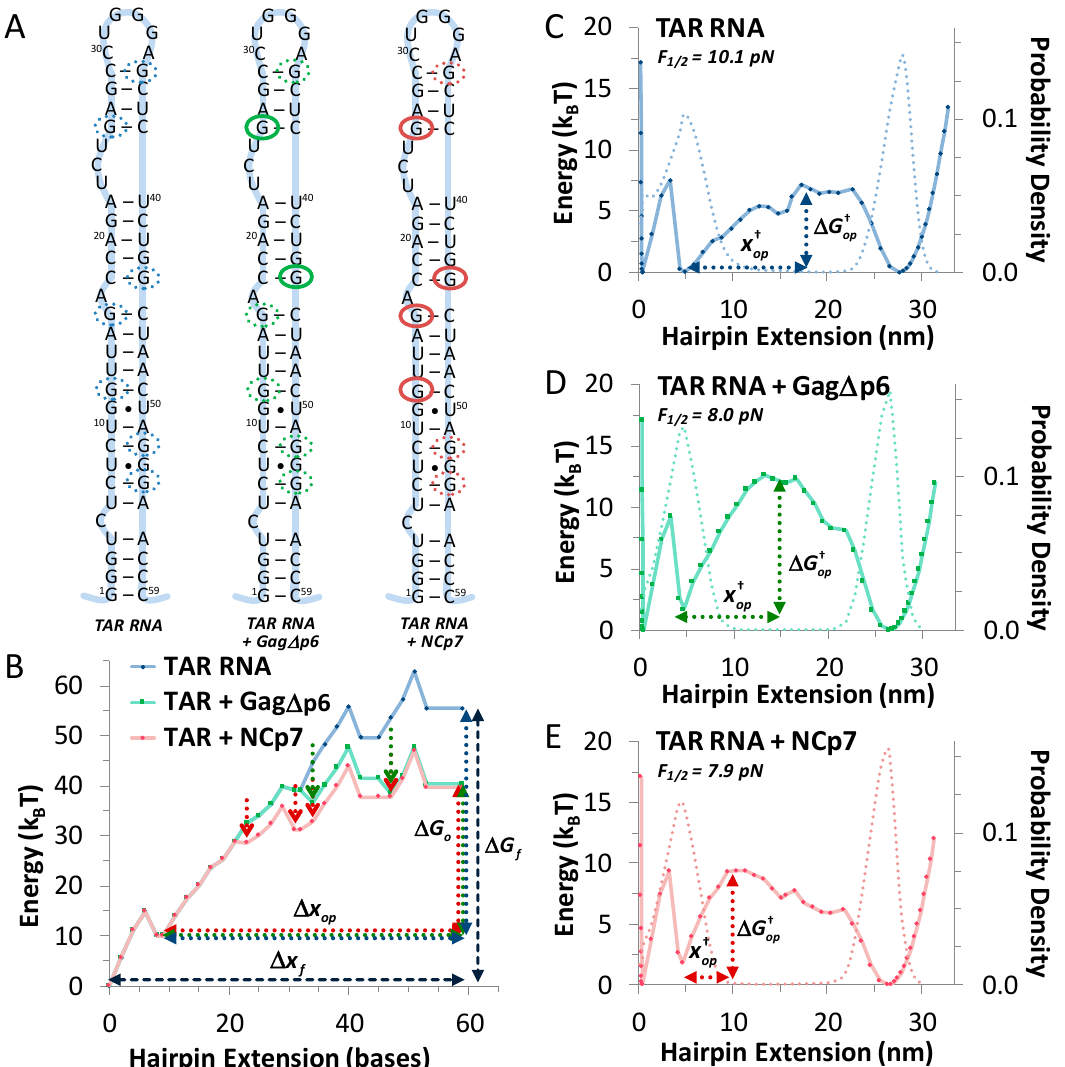
Figure 4. Quantitative modeling of critical protein binding sites. ( A ) Predicted mfold structure for TAR RNA hairpin, highlighting exposed G bases (dotted blue circles). Gag ∆ p6 binding model incorporates binding to two sites (green–solid circles are confirmed sites in our model), while NC binding is shown for a four-site model (solid red circles). ( B ) Progressive energy of unfolding per extension, as predicted by mfold for TAR (blue), G i ( N i , F = 0). Protein binding is modeled by reducing marked sites (green and red arrows) by a discrete amount (4 k B T for NC and 8 k B T at each site for Gag ∆ p6). Predictions for the total energy ( ∆ G o ) and change in length ( ∆ x op ) are shown, compared to the total hairpin energy ( ∆ G f ) and length ( ∆ x f ) from mfold. This unfolding landscape may be ‘tilted’ by the effect of an external force ( − F ∆ x ). ( C ) Critical force landscapes for TAR (blue), ( D ) TAR + Gag ∆ p6 (green) and ( E ) TAR + NCp7 (red), including potentials (solid lines for G i ( N i , F ½ ), G i,Gag ∆ p6 ( N i , F ½ ) and G i,NCp7 ( N i , F ½ )) and probability densities (dotted lines), as discussed in the text. The forces, where P op = P cl are identified for each, with values for the distance to the opening barrier ( ∆ x † op ) and height ( ∆ G † op ). Predicted state parameters are summarized in Table 1.